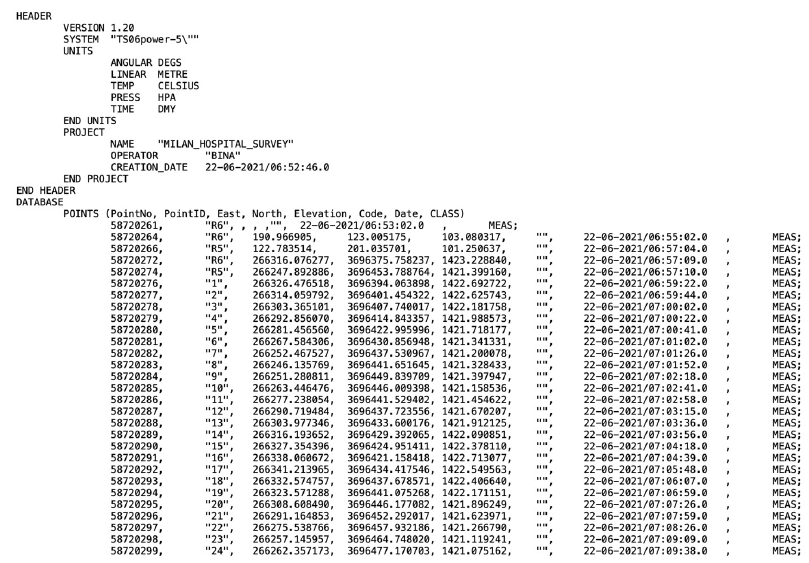
Figure 3. Example of acquired data of the soil deposit and construction site.